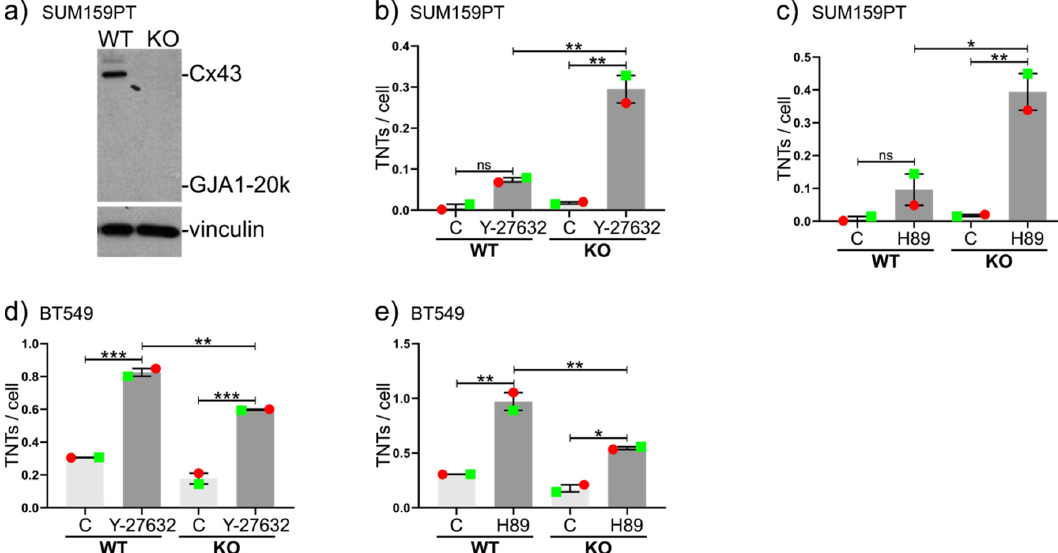
Figure 4. Drug-induced TNT formation in SUM159PT and BT549 cells. ( a ) Western blot of WT